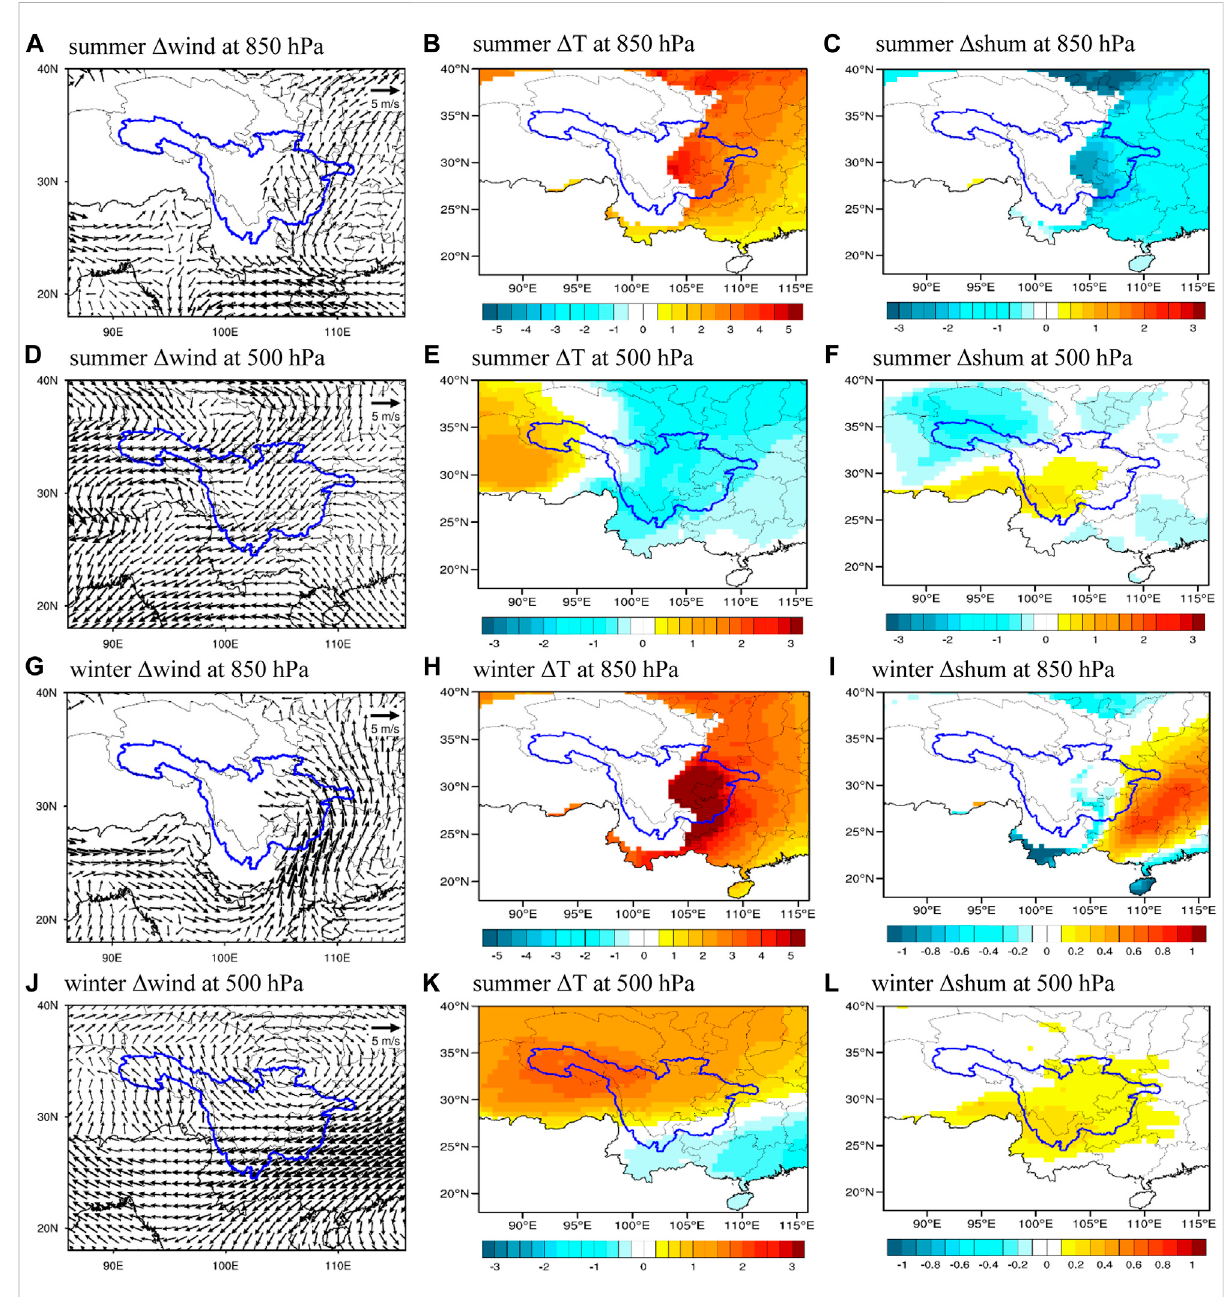
FIGURE 9 Difference in the wind fi eld (m/s), temperature ( ° C), and speci fi c humidity (g/kg) between CLM3.5 and BATS (de fi ned as CLM3.5-BATS). [ (A) differenceinsummerwindsat850 hPa, (D) differenceinsummerwindsat500 hPa, (G) differenceinwinterwindsat850 hPa, (J) differenceinwinter winds at 850 hPa; (B,E,H,K) same as (A,D,G,J) but for temperature; and (C,F,I,L) same as (A,D,G,J) but for speci fi c